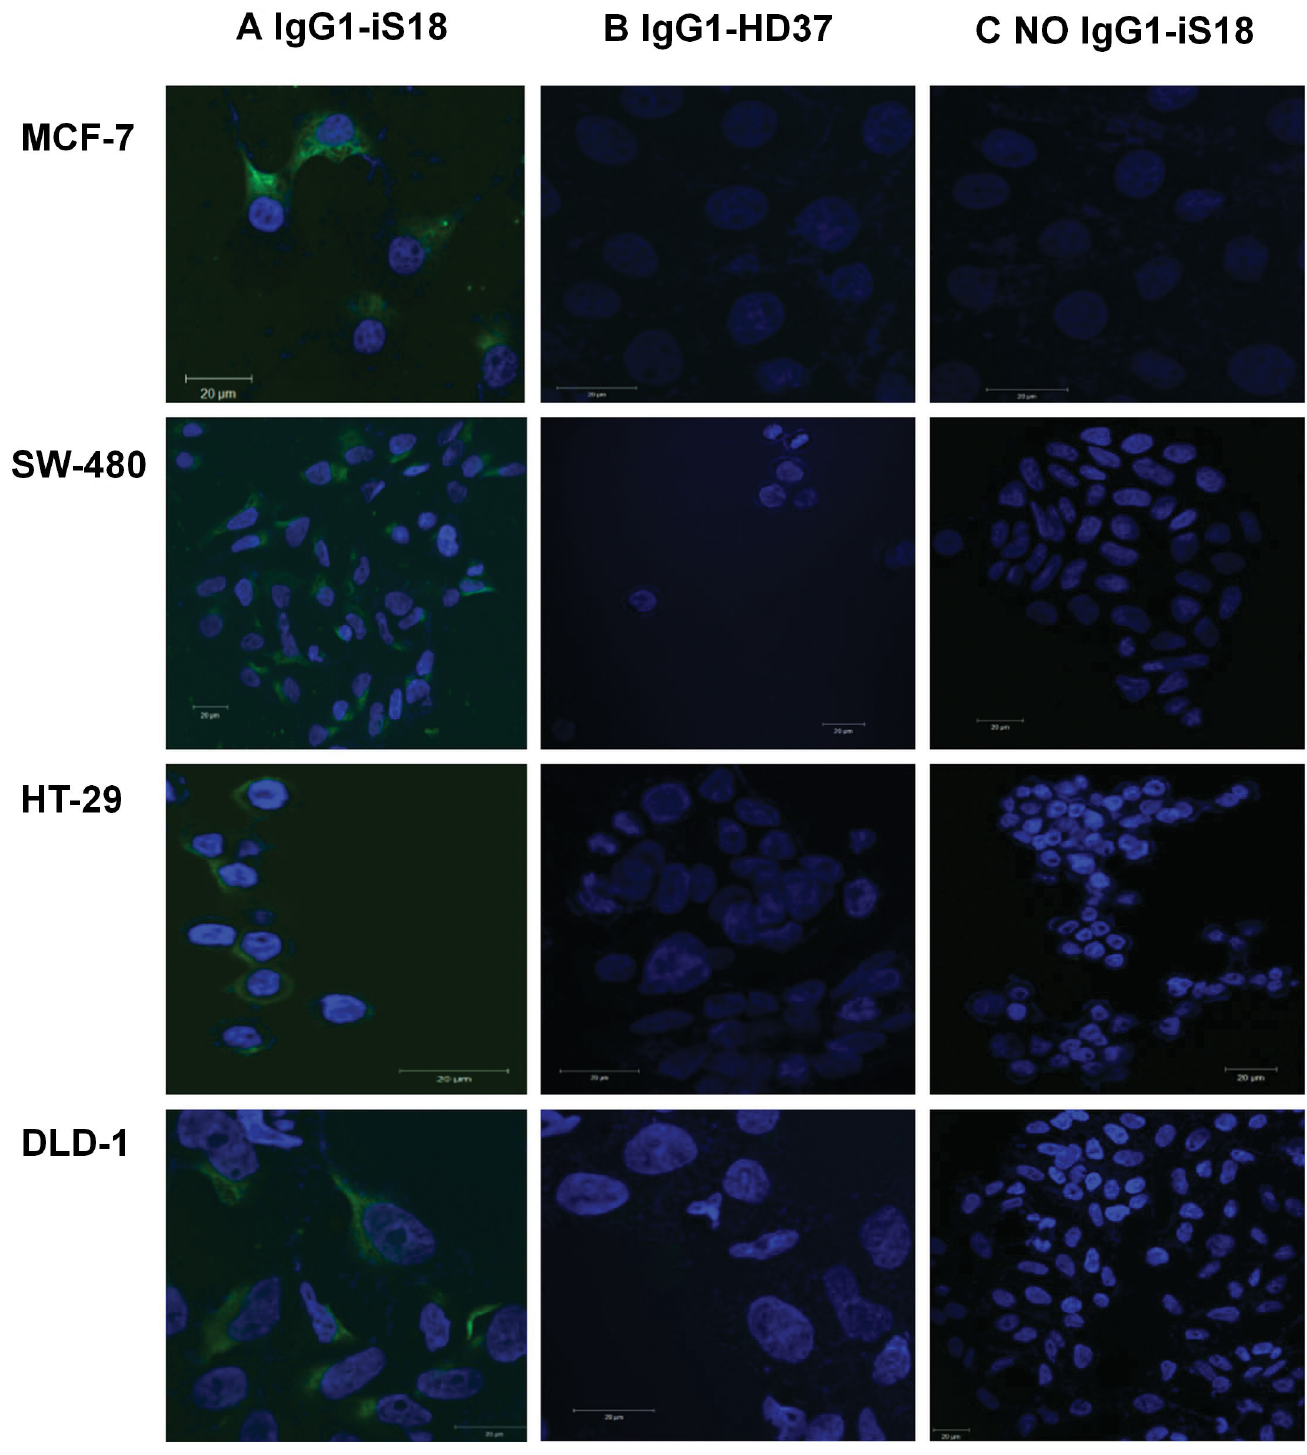
Figure 1. Visualization of LRP/LR on the surface of early-stage (SW-480 and HT-29) and late-stage (DLD-1) colorectal cancer and poorly invasive (MCF-7) tumorigenic cells. (A) Cells labeled with primary antibody IgG1-iS18 and FITC-coupled secondary antibody specific for IgG1-iS18 and found to fluoresce green. (B) Cells labeled with IgG1-HD37 antibody serving as negative control. (C) Cells labeled with only the FITC-coupled secondary antibody to confirm that there was no nonspecific binding coming from the secondary